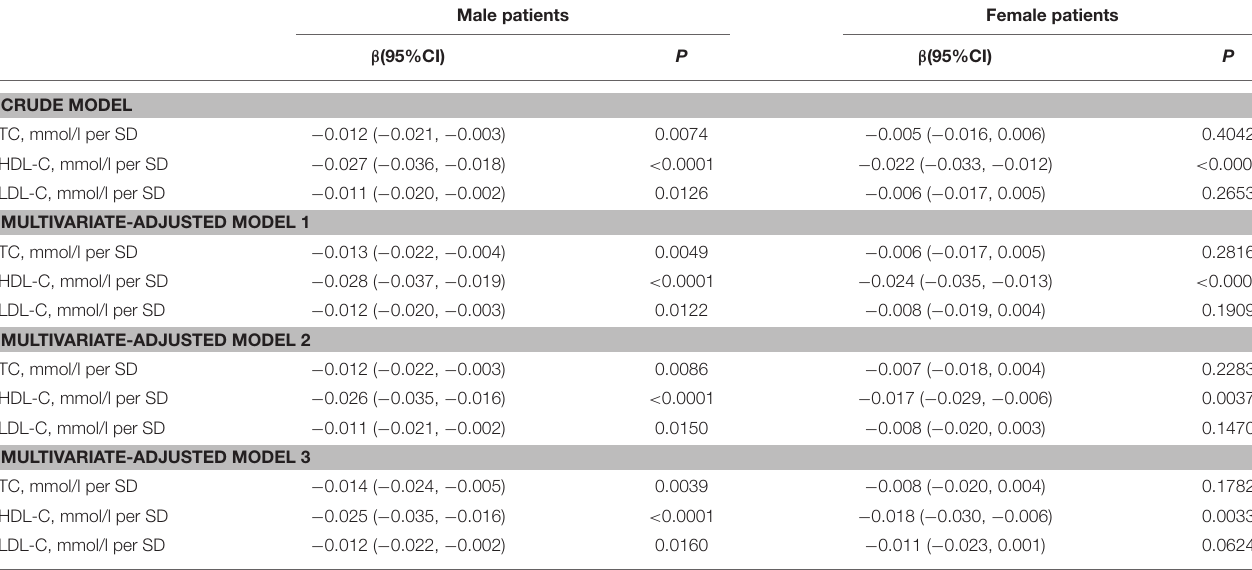
TABLE 3 | Multivariate Regression for Effect of TC, HDL-C, and LDL-C on femur neck BMD.